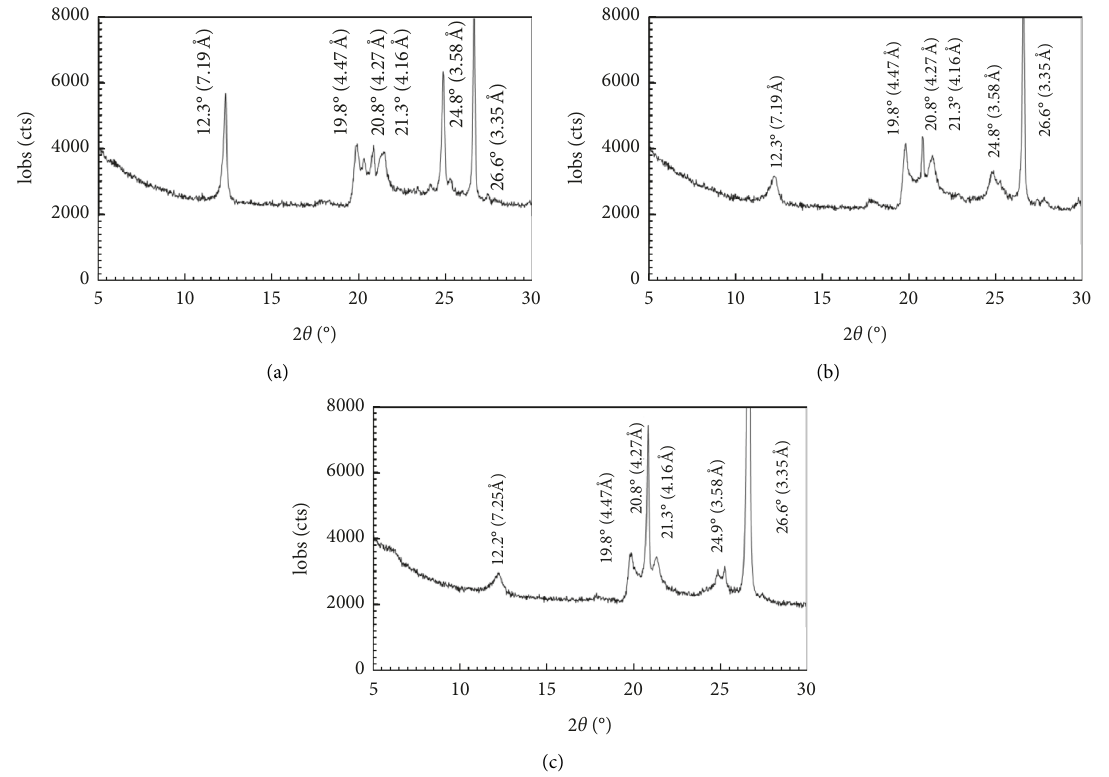
Figure 3: XRD curves of S-1 ∼ S-3. (a) Original sample of S-1(Guilin). (b) Original sample of S-2(Liuzhou). (c) Original sample of S- 3(Laibin). Table 2: Main mineral compositions of lateritic clay samples. Sample